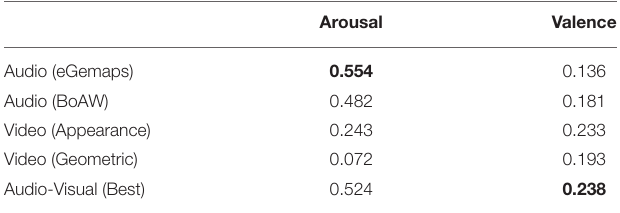
TABLE 3 | RankSVM evaluation with different modalities in terms of Kendall’s tau ( τ ).